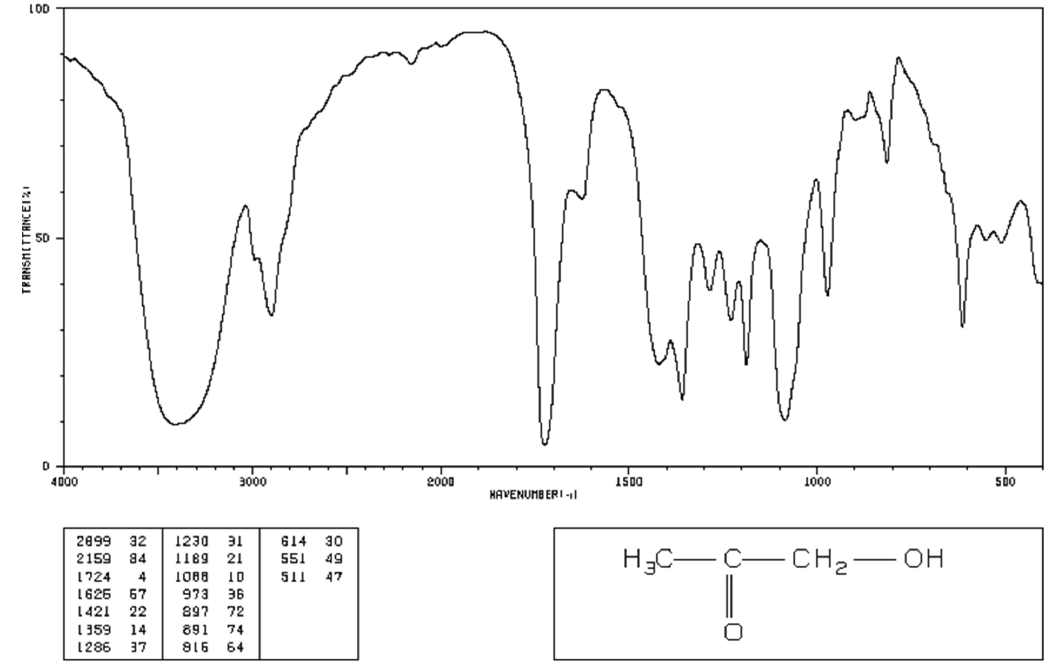
Figure 12. FTIR spectrum of hydroxyacetone [50].